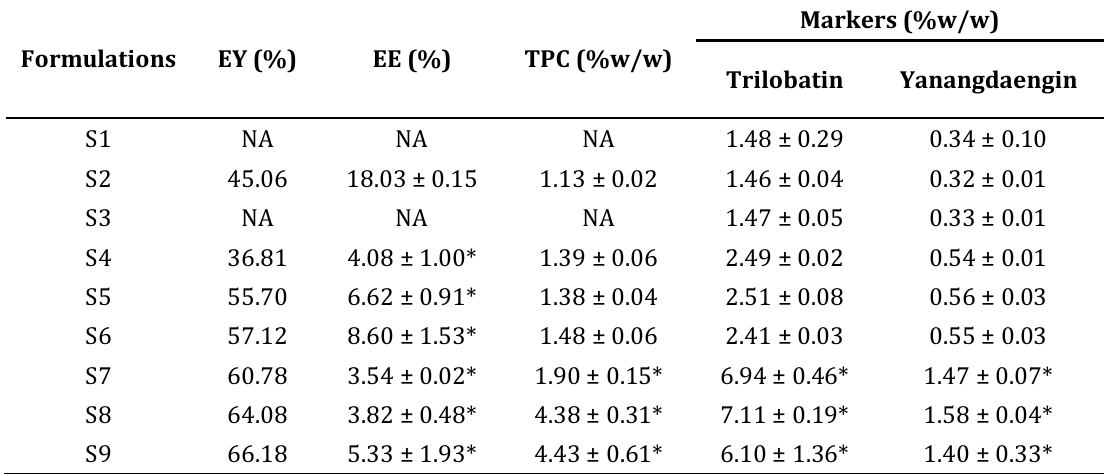
Table 2: Effects of spray - drying variables on drying outcomes and properties of LS microcapsules.